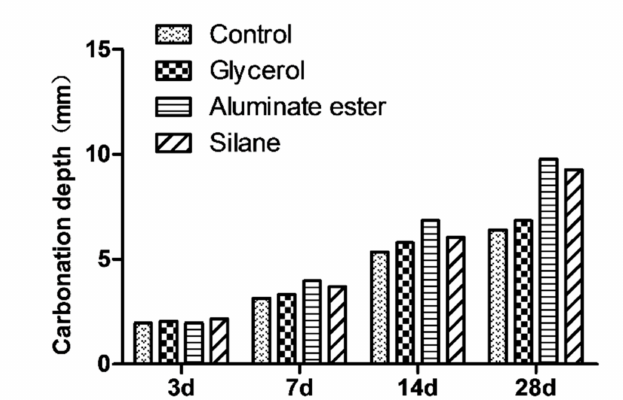
Figure 9. Carbonation depth of four mixtures at di ff erent